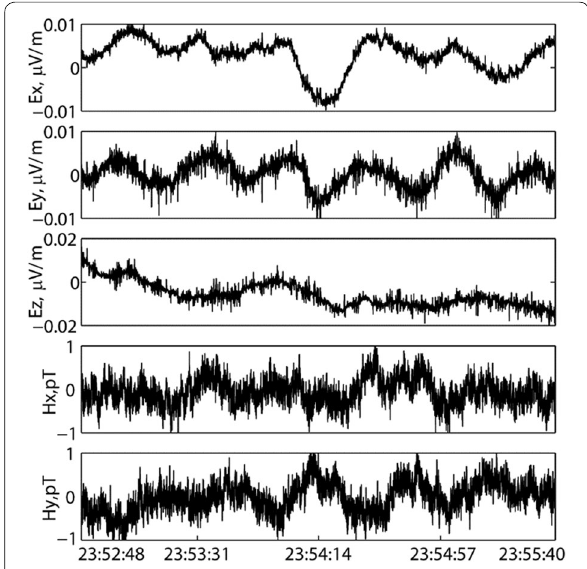
Fig. 8 Noise-canceled time series windows of five component EM fields from the SH-R11 site, shown in Fig. 5. The five plots from top to bottom illustrate the five EM components without